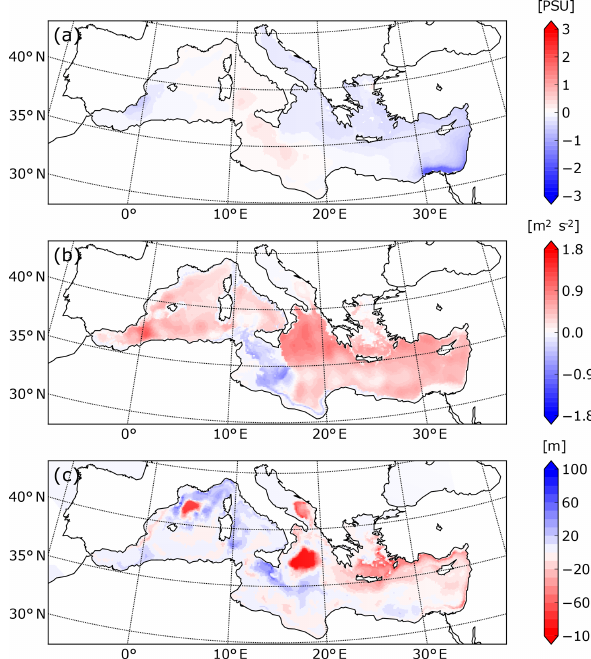
Figure 12. Deviations between EHOL and PICTRL in (a) sea sur- face salinity, (b) index of stratification and (c) mixed-layer depth, averaged over the last 30 years of